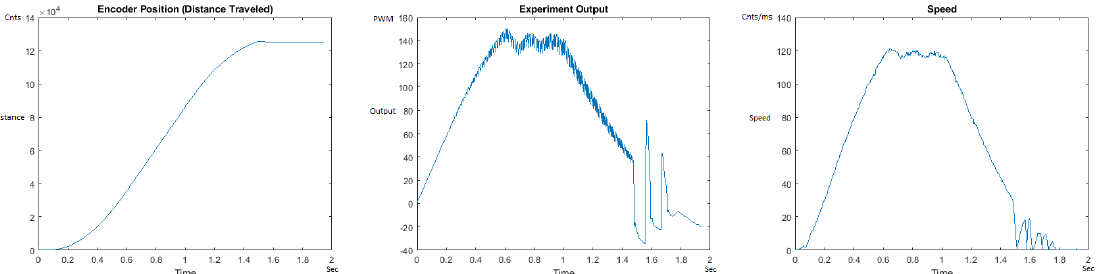
Figure 21. Encoder position, output and speed plots for PID++ UP operation— Vmax 120 cnts/ms, Adesired 0.055 cnts/ms 2 — 10